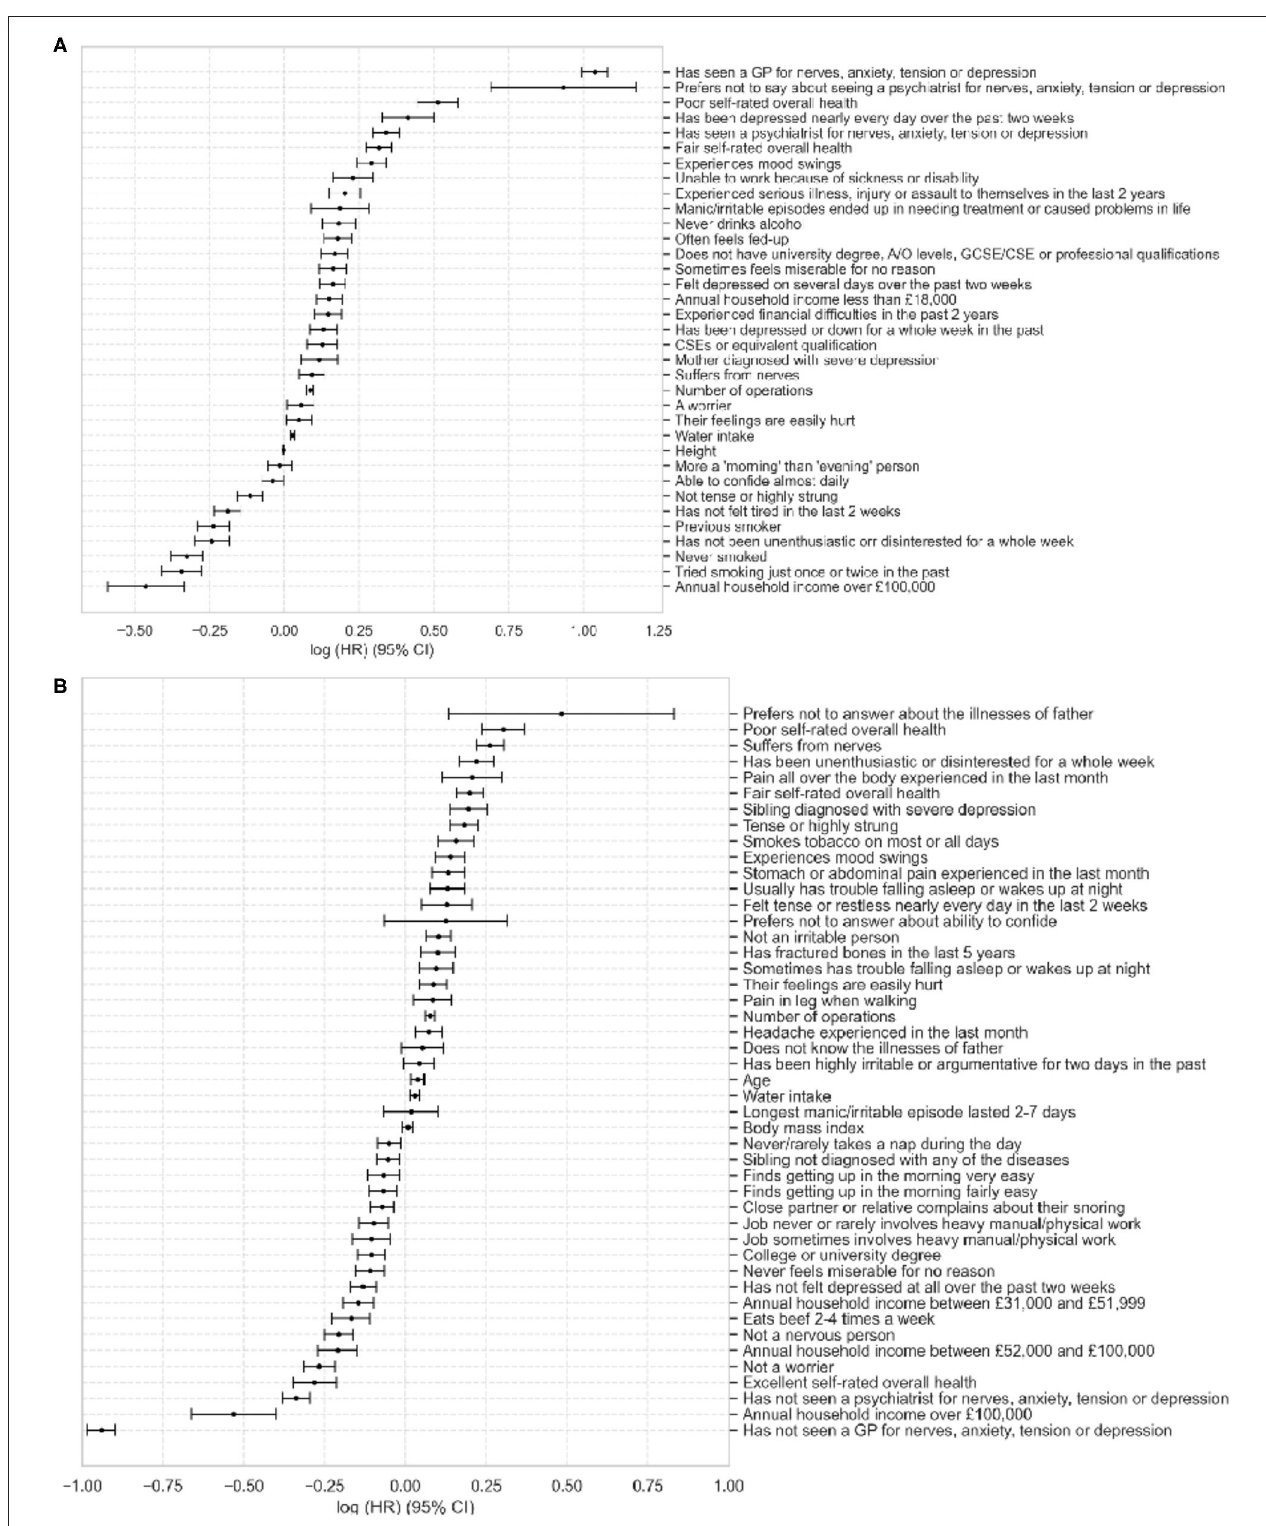
FIGURE 1 | Plot of Cox Proportional Hazards model coefficients for depression (A) and anxiety (B) . Values show log(HR) ± 95% CI. HR = hazard ratio, CI = confidence interval.